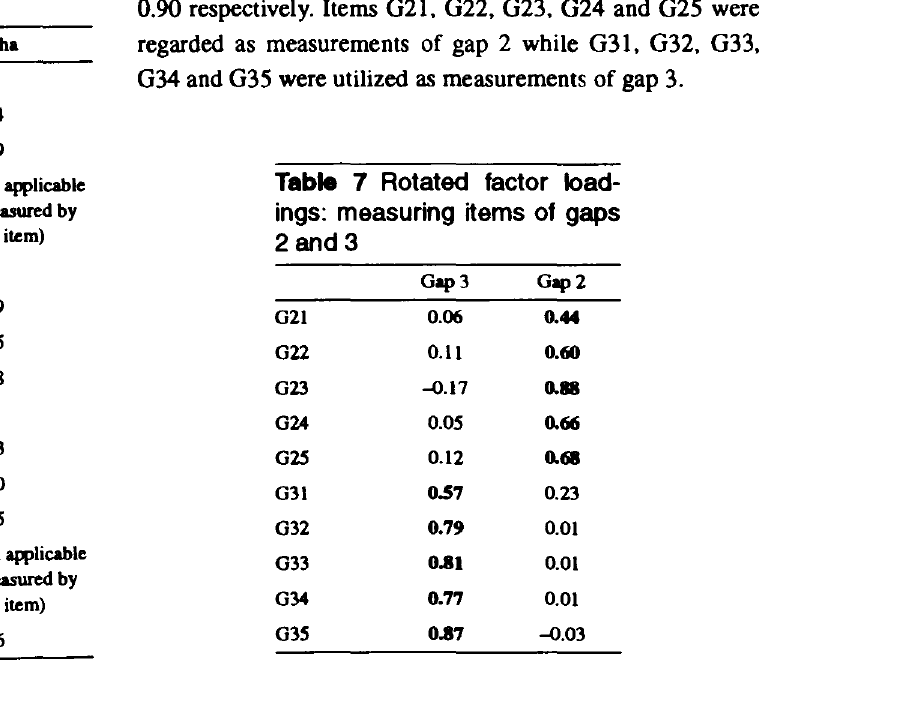
Table 7 Rotated factor